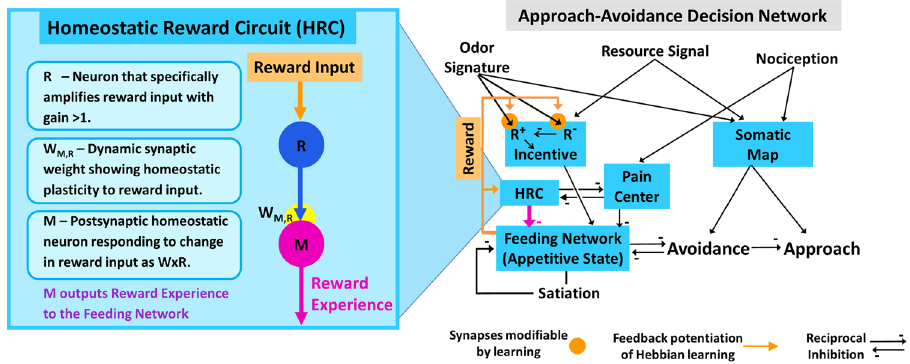
Figure 1. ASIMOV’s neural network of foraging decision. Right: In the modified decision network from Cyberslug 3 , Appetitive State (feeding network excitation) sums intrinsic and learned stimulus values as Incentive with motivation (Satiation) to regulate turn response direction. In parallel, a map of stimuli (Somatic Map) from the animal’s oral veil sets turn amplitude. Incentive sums sensory inputs predicting nutritional value (Resource Signal) with learned positive and negative values of prey odor signatures (R + and R-), and is then integrated with motivation, Reward Experience, and Pain into Appetitive State (Feeding Network excitation). Positive and negative classical learning occur by outputs from the feeding network operating in approach or avoidance modes, respectively. Left: The Homeostatic Reward Circuit (HRC) mediates habituation to rewarding cues, the basis of Drug desensitization and withdrawal. HRC integrates rewards from prey consumption as Reward Experience and reduces Appetitive State in negative feedback. HRC comprises two connected rate- based neurons, R and M. R receives and amplifies reward output from Feeding Network. Neuron M expresses homeostatic plasticity, habituating to reward. M’s activity is a product of the dynamic synaptic weight W and neuron R’s activity. HRC activity lies in reciprocal inhibition with the Pain Center output; higher levels of pain suppress Appetitive State and cause aversion to painful stimuli. Thus, pain’s suppressive effect is reduced by positive reward output from